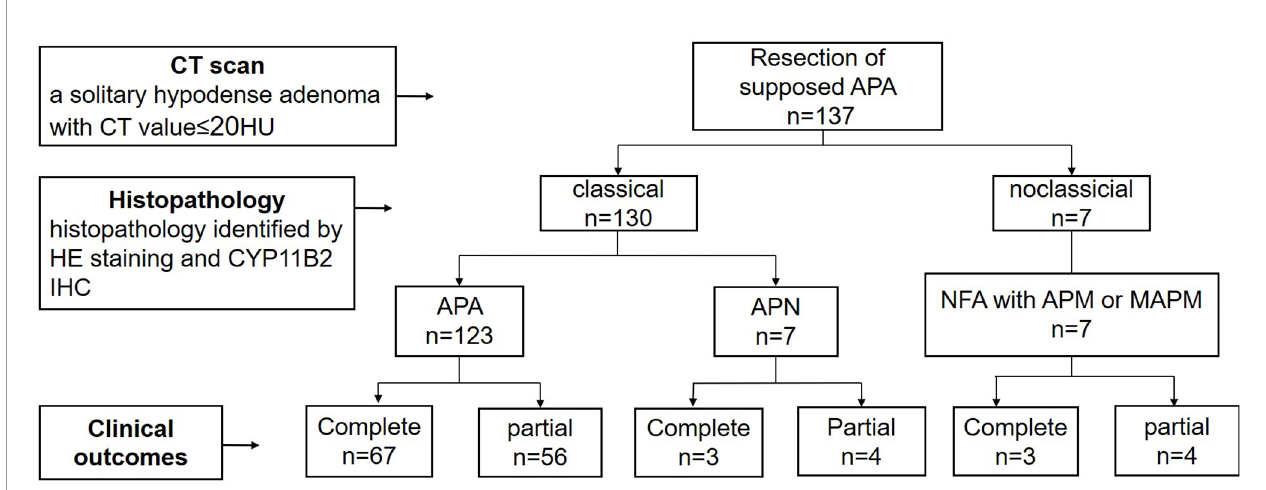
FIGURE 1 | The procedure about preoperative diagnosis of APA, histopathology diagnosis and clinical outcomes. APA, aldosterone producing adenoma; APN, aldosterone-producing nodule; NFA, non-functional adenoma; APM, aldosterone-producing micronodule; MAPM, Multiple aldosterone-producing